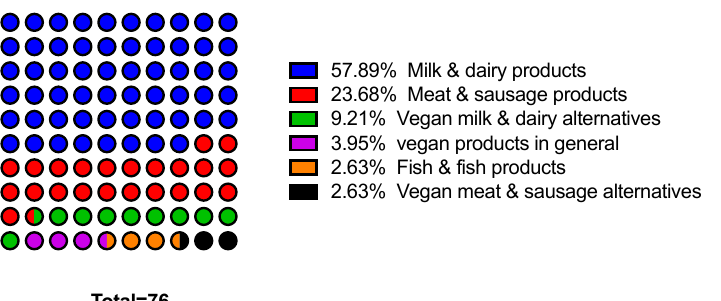
Figure 4. Commercially available protective cultures by food application.